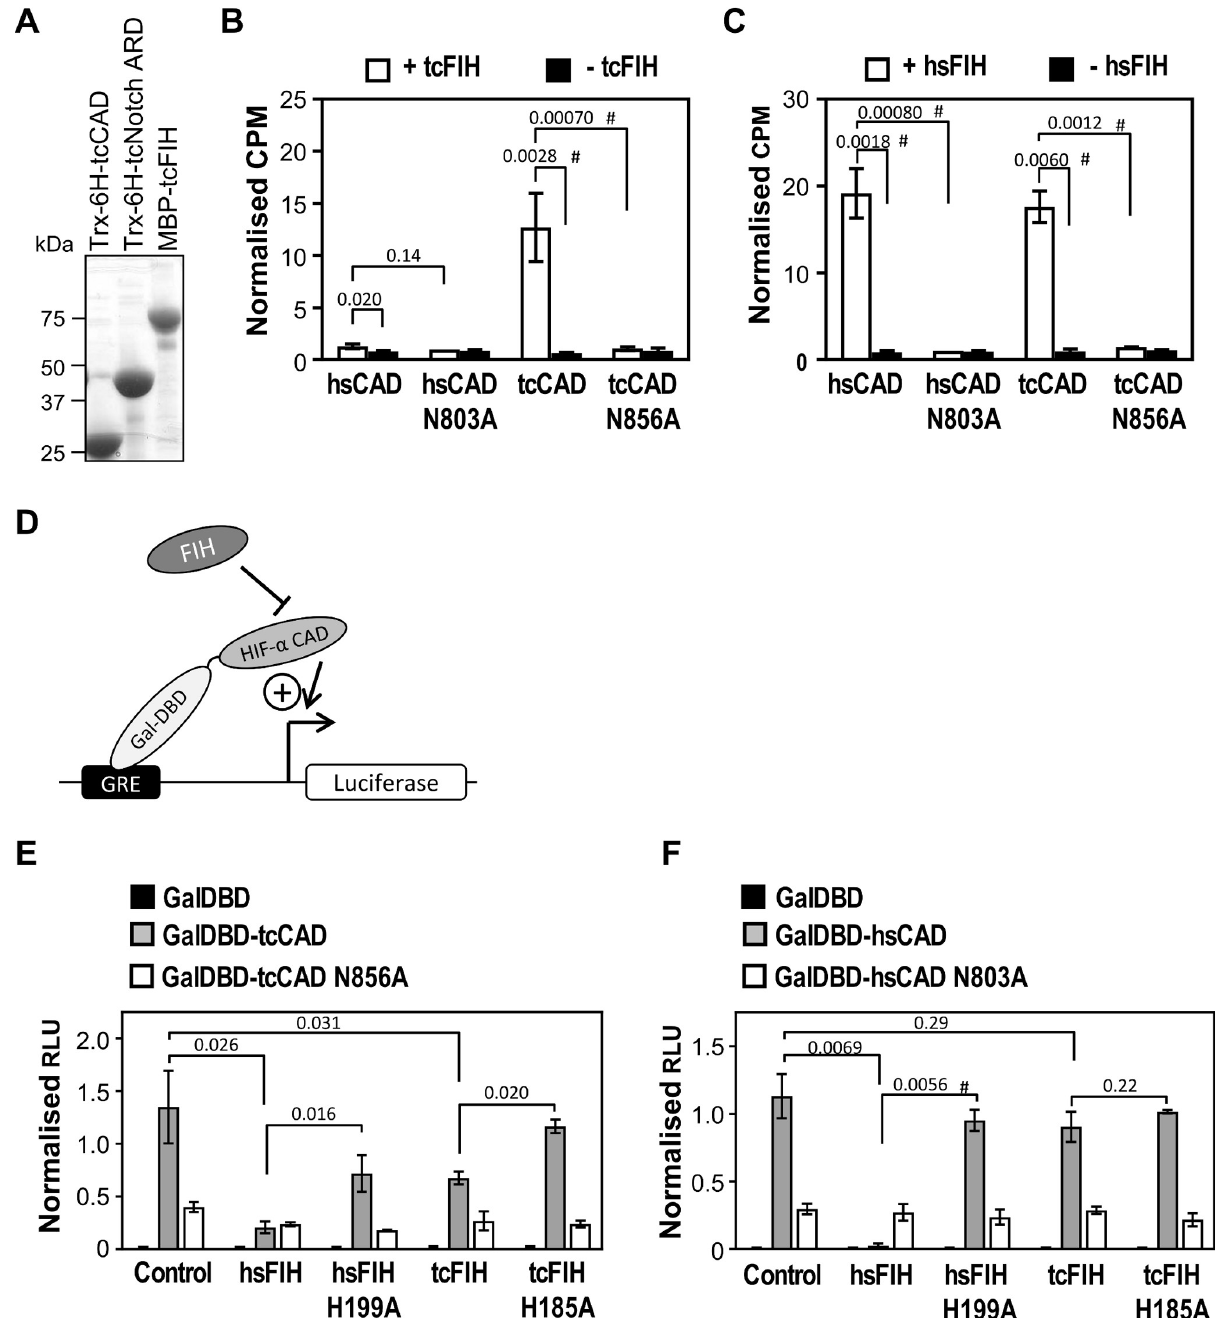
Fig 7. T. castaneum FIH is a putative asparaginyl hydroxylase that hydroxylates HIF- α substrates. (A) Thioredoxin-6 Histidine-tagged-tcHIF- α (790–879) (Trx-6H-tcCAD), Trx-6H-tcNotch (1747–1989) (Trx-6H-tcNotch ARD) and maltose binding protein-tagged tcFIH (MBP-tcFIH) were expressed in E. coli, purified by Ni 2+ affinity or amylose agarose chromatography, and analysed by Coomassie-stained SDS-PAGE. (B) In vitro hydroxylation reactions were set up containing 60 μ M tcHIF- α CAD (tcHIF- α residues 790–879), hsHIF-1 α CAD (hsHIF-1 α residues 736–826) and their corresponding Asn mutants, and either 1 μ M tcFIH (white bars, analysed in triplicate) or buffer (black bars, analysed in duplicate). Reactions were incubated at 37˚C degrees for 30 min, and then the counts per minute (CPM) of [ 14 C]CO 2 released during the reaction analysed by scintillation counting. Data were normalised to CPM observed for the hsHIF-1 α CAD N803A + FIH sample. Bars are mean +/- SEM of combined data from 3 independent experiments. (C) As for part B, but using hsFIH enzyme. (D) Schematic representation of the reporter gene assay used to test transactivation capacity of tcHIF- α CAD. A firefly luciferase reporter gene downstream of a Gal4 response element (GRE) is transfected into mammalian cells. The GRE facilitates recruitment of yeast Gal4-DNA-binding domain (GalDBD)-tagged HIF- α CAD proximal to the luciferase gene